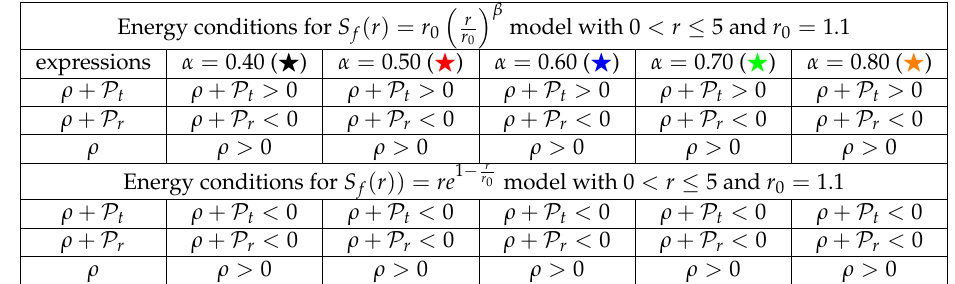
Figure 7. The variational behavior of ρ + P t . Here, α = 0.10 ( (cid:70) ), α = 0.20 ( (cid:70) ), α = 0.30 ( (cid:70) ), α = 0.40 ( (cid:70) ), α = 0.50 ( (cid:70) ), β = 0.25, and γ = 0.10. Table 2. Summary of the